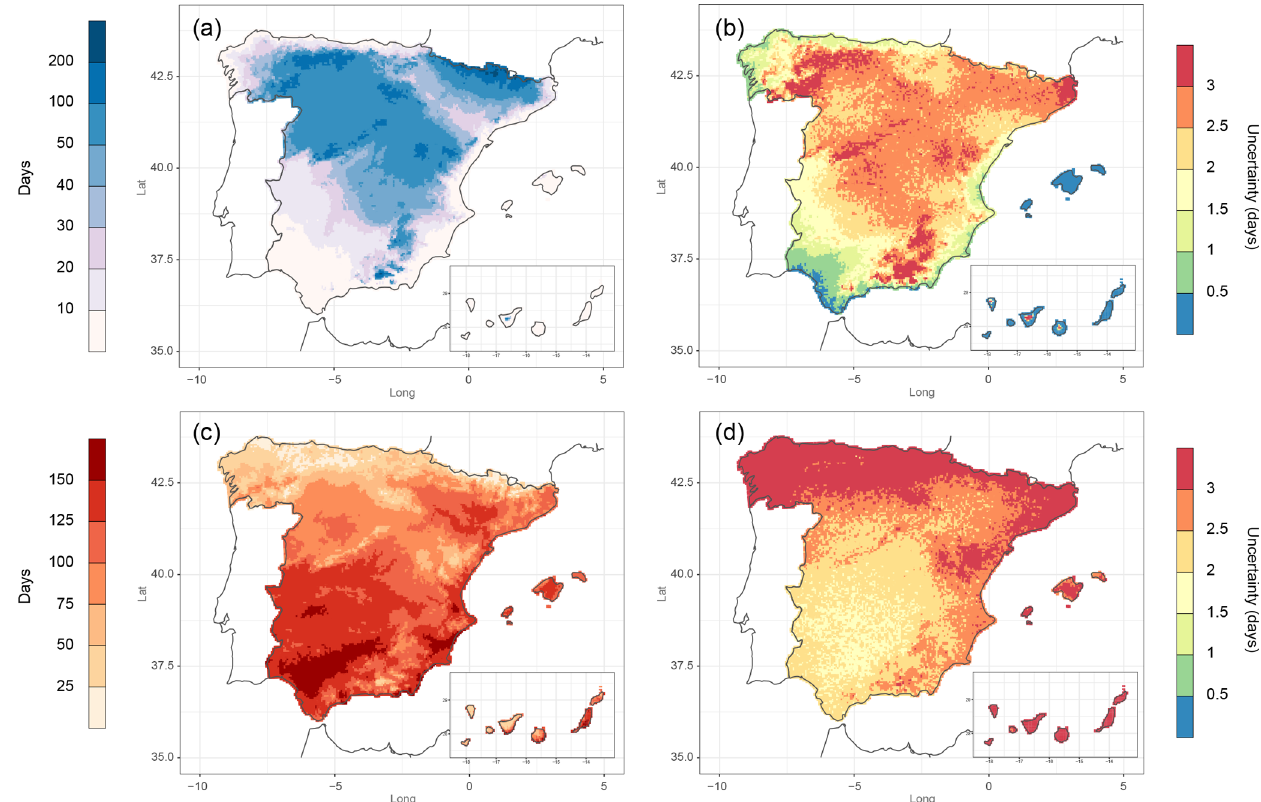
Figure 13. Mean annual (1981–2010) values for (a) number of frost days, (c) number of summer days and their corresponding uncertainty ( b, d ,